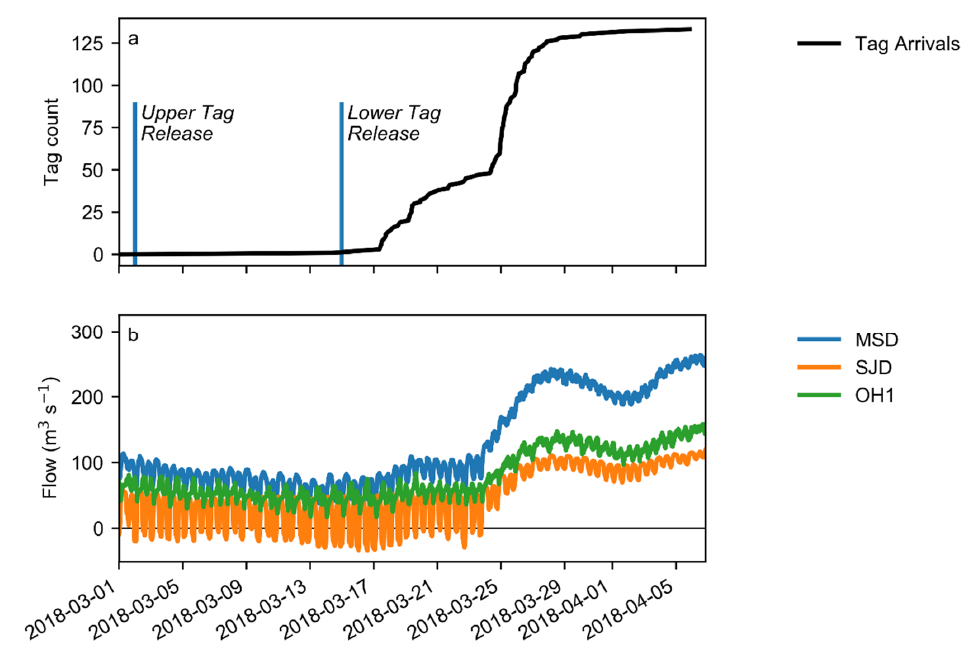
Figure 2. Chronology of ( a ) tagged fish release and cumulative arrival in the study area, and ( b ) measured flow upstream ( b ) measured flow upstream of the diffluence at Mossdale (MSD), downstream of the diffluence on of the diffluence at Mossdale (MSD), downstream of the diffluence on the San Joaquin River at Dos Reis (SJD) and down- stream of the diffluence on Old River (OH1). the San Joaquin River at Dos Reis (SJD) and downstream of the diffluence on Old River